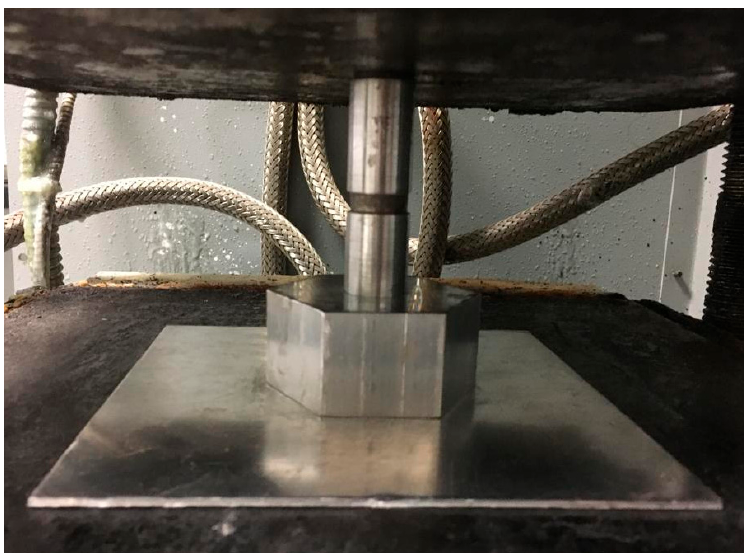
Figure 3. Stainless steel mold containing the powder that is packed using the hydraulic press ma- chine.